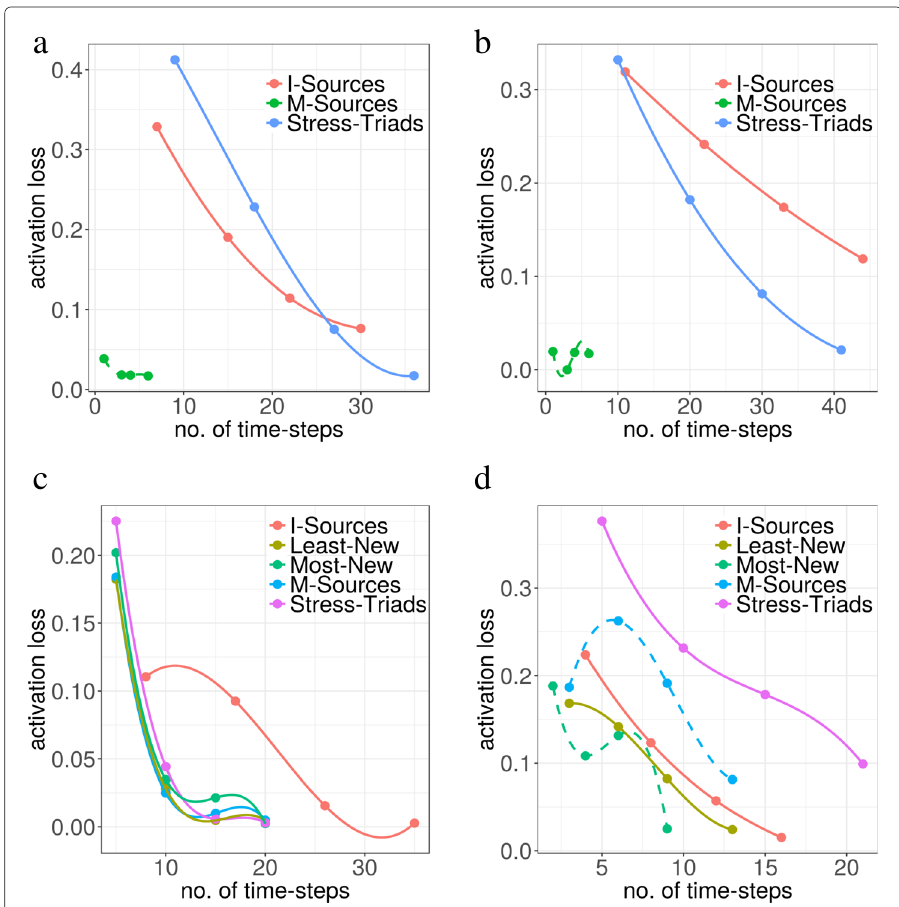
Fig. 11 Activation loss due to time-varying quiescence (for λ = 5, k = 50) under the nC - F 2 DLT model. a Epinions. b Slashdot. c Wiki-Conflict. d